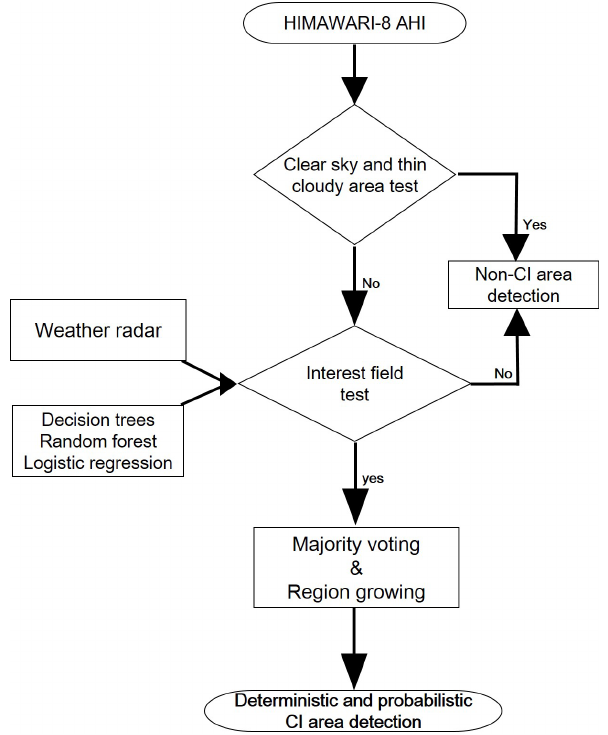
Figure 1. Processing flow of deterministic and probabilistic CI de- tection based on machine learning and statistical